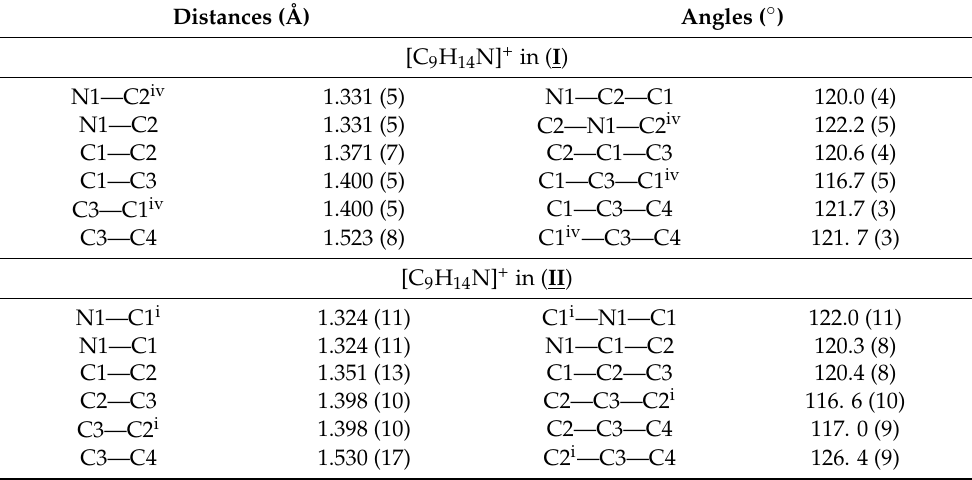
Table 4. The main interatomic distances (Å) and angles ( ◦ ) of the organic group of ( I ) and of ( II ). Distances (Å) Angles ( ◦ ) [C 9 H 14 N] + in ( I